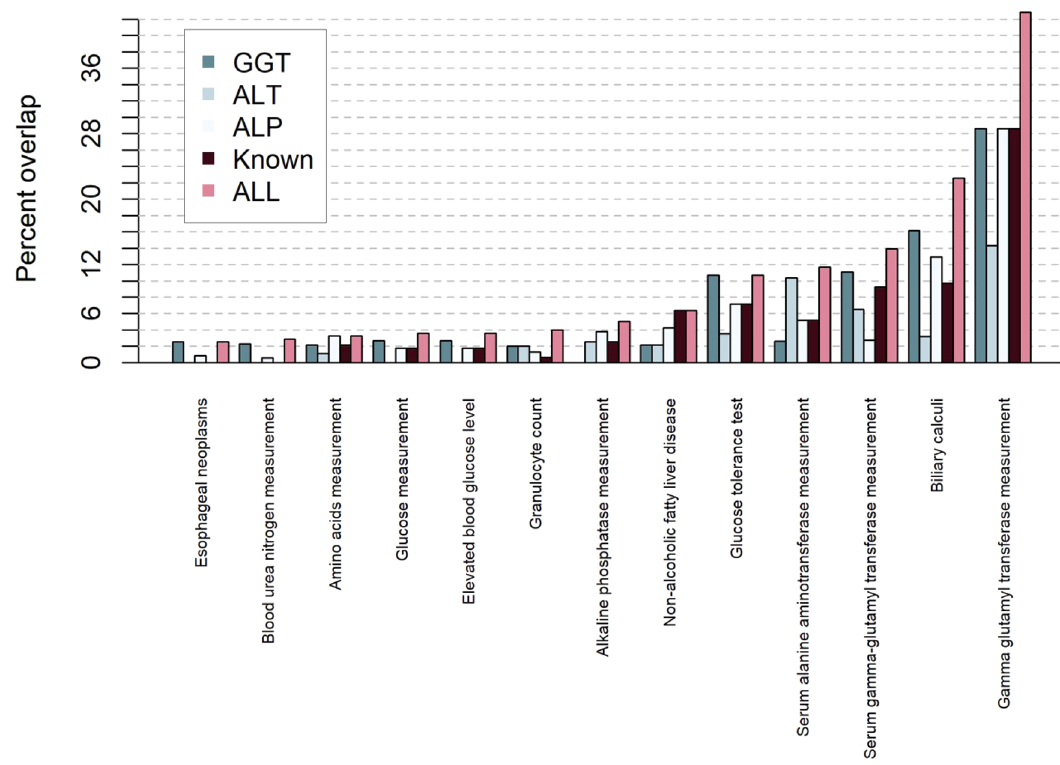
Fig. 4 Overview of diseases and traits known to be related to liver enzyme SNPs using DisGeNET. Previous knowledge on the association of all (pink), known (brown), ALT (stone), ALP (light gray), and GGT(aegean) loci are